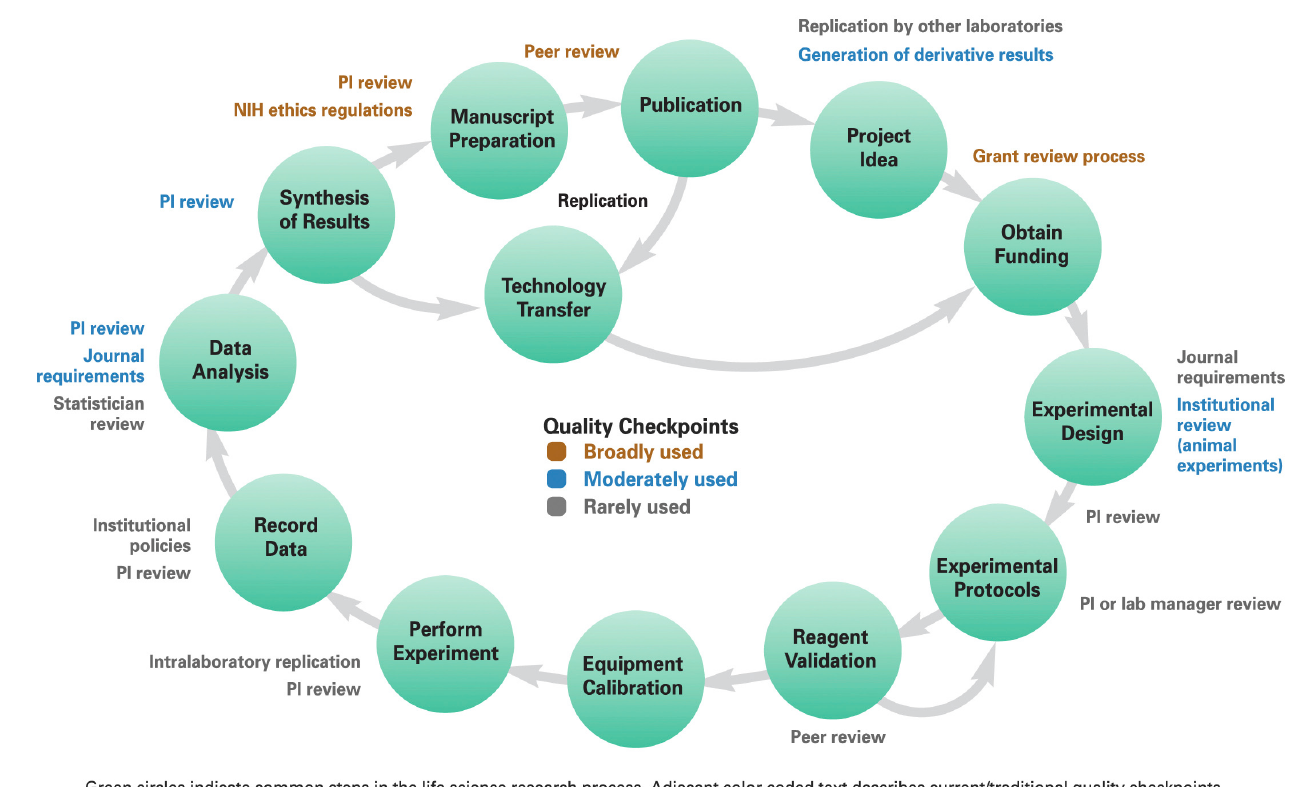
Figure 1. Many opportunities exist to improve reproducibility across the research life cycle. Figure from